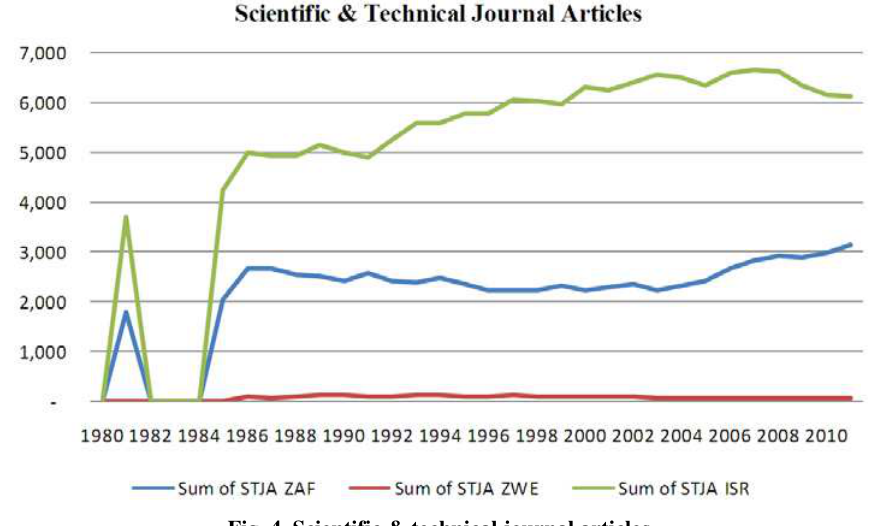
Fig. 4. Scientific & technical journal